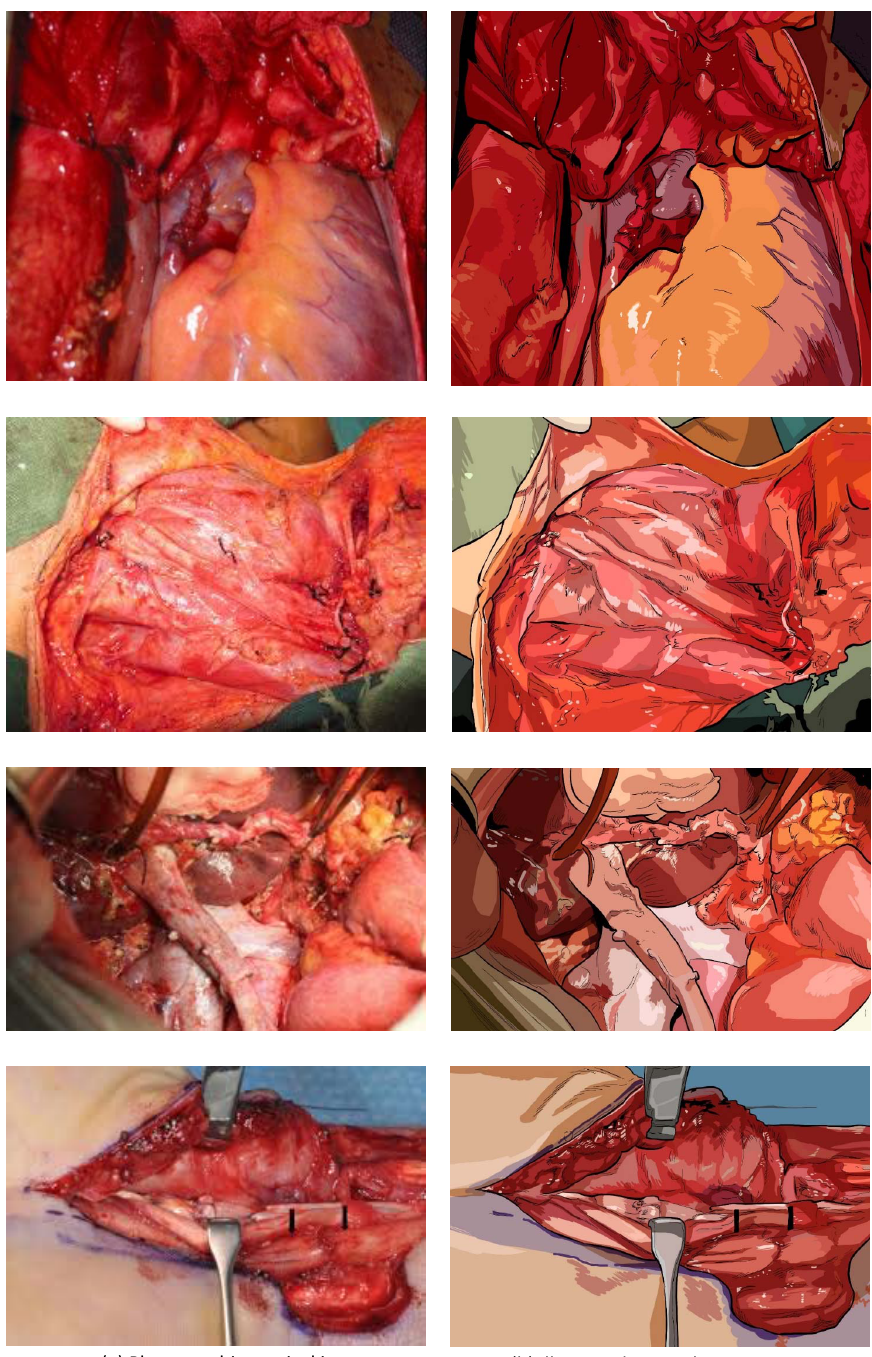
Figure 2. The second comparison of photographic surgical images and illustrated surgical